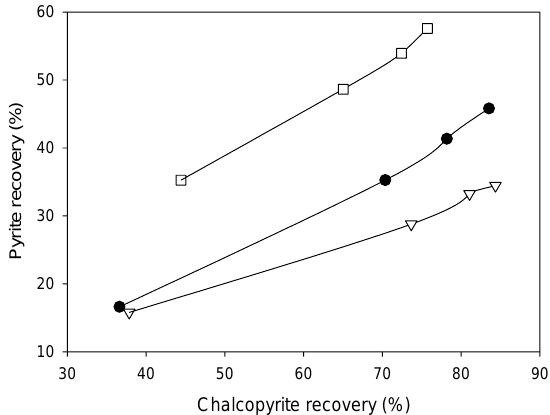
Figure 32. Pyrite and chalcopyrite flotation as a function of flotation time and ZnSO 4 concentration of (□) 0 g/t, (●) 500 g/t, and (∆) 2000 g/t (pH = 9.0; [SIPX] = 200 g/t; conditioning Eh = 275 mV, SHE) (adapted from He et al. [125]).